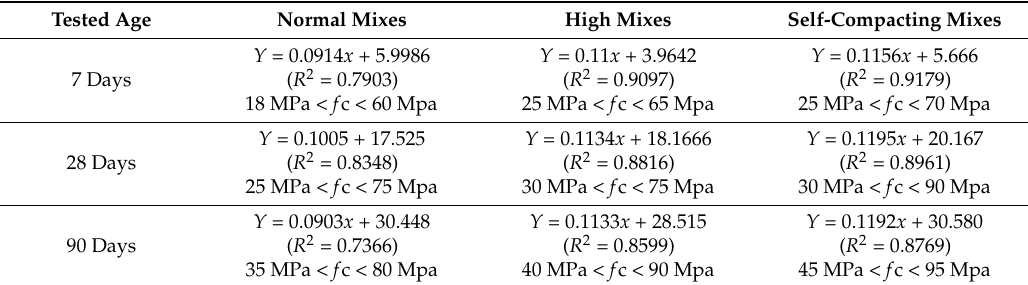
Table 6. Linear equations for compressive strength at 7, 28 and 90 days’ strength.